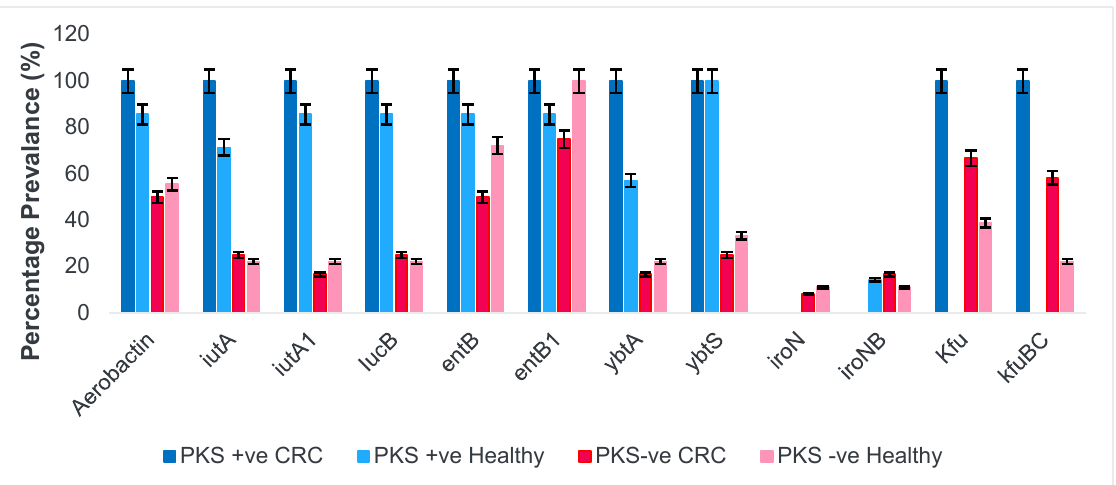
Figure 1. Presence of siderophores and iron uptake systems among K. pneumoniae isolates. Aerobactin Figure 1 : Presence of siderophores & iron uptake systems among K. pneumoniae siderophore, ferric aerobactin receptor ( iutA, iutA1,iucB ), enterobactin siderophores ( entB, entB1 ), Yersiniabactin siderophore ( ybtA, ybtS ), salmochelin catecholate receptor ( iroN, iroNB ) and Klebsiella isolates. Aerobactin siderophore, Ferric aerobactin receptor ( iutA, iutA1,iucB ), Enterobactin iron uptake systems ( kfu, kfuBC siderophores ( entB, entB1 ), Yersiniabactin siderophore ( ybtA, ybtS ), Salmochelin catecholate receptor ( iroN, iroNB ) and Klebsiella iron uptake systems ( kfu, kfuBC ).